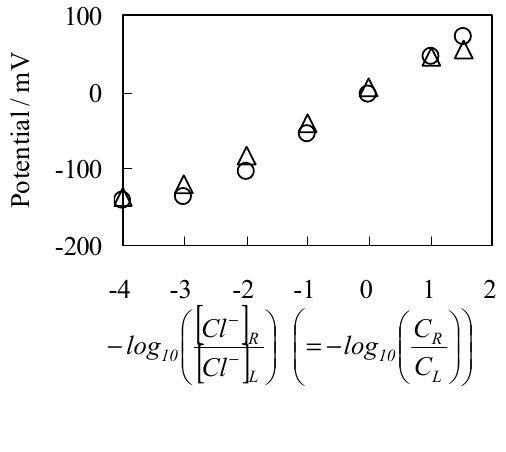
Figure 10. Potential generated between two KCl solutions vs. − log([Cl − ] ○ : Potential across the permeable membrane of Selemion AMV (same data as that shown in Figure 3); ∆ : Potential across the impermeable membrane of SES